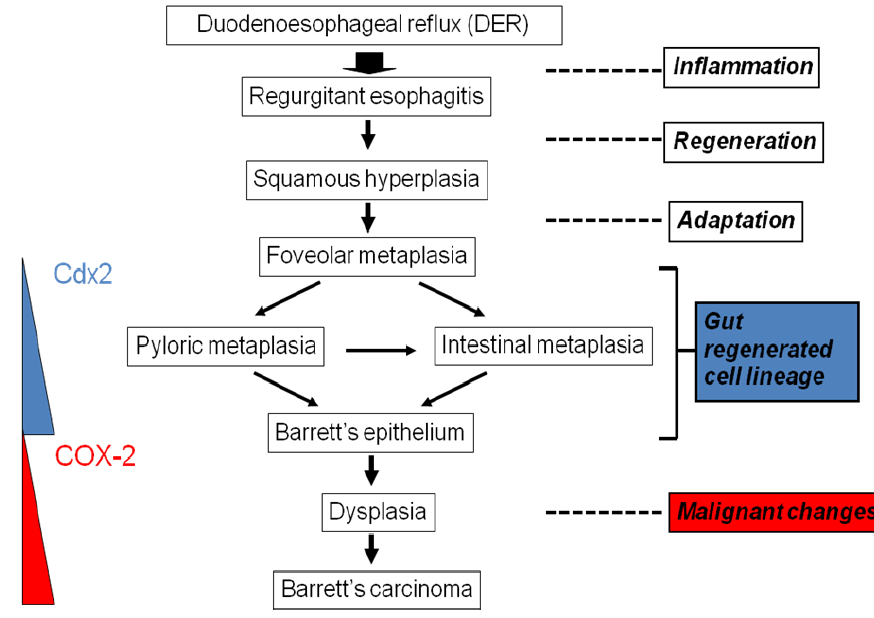
Figure 7. Metaplasia-dysplasia-carcinoma sequence in reflux model.